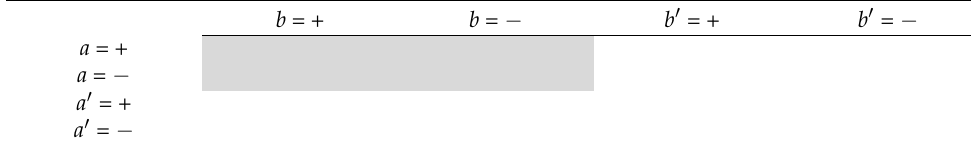
Table A1. A sequence of tables to illustrate the implications of S > 2: a and b .